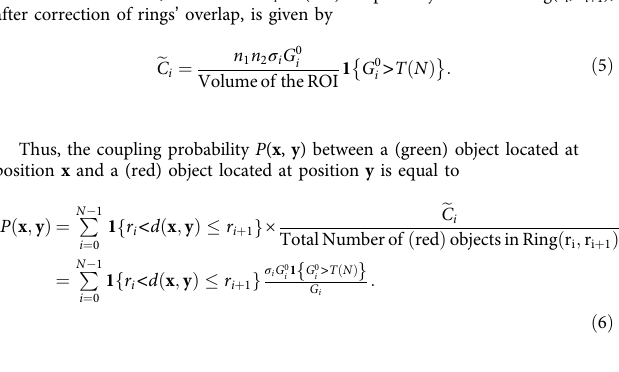
ffiffiffiffiffiffiffiffiffiffiffiffiffiffiffiffiffiffiffiffiffiffiffiffiffiffiffiffiffiffi A 2 i (cid:3) ð A i þ B SNR 2